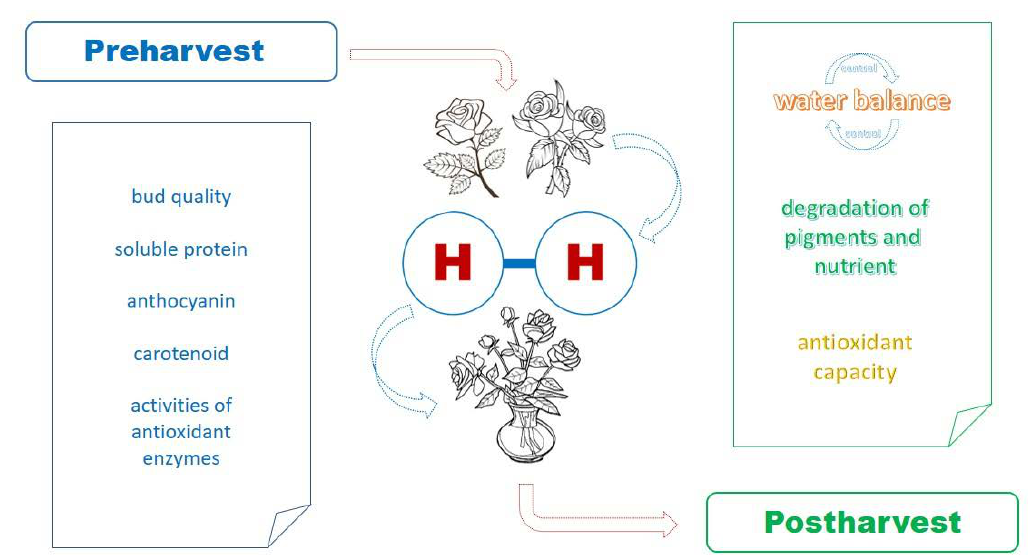
Figure 2. The physiological diagram for the study of floral senescence causes and hydrogen